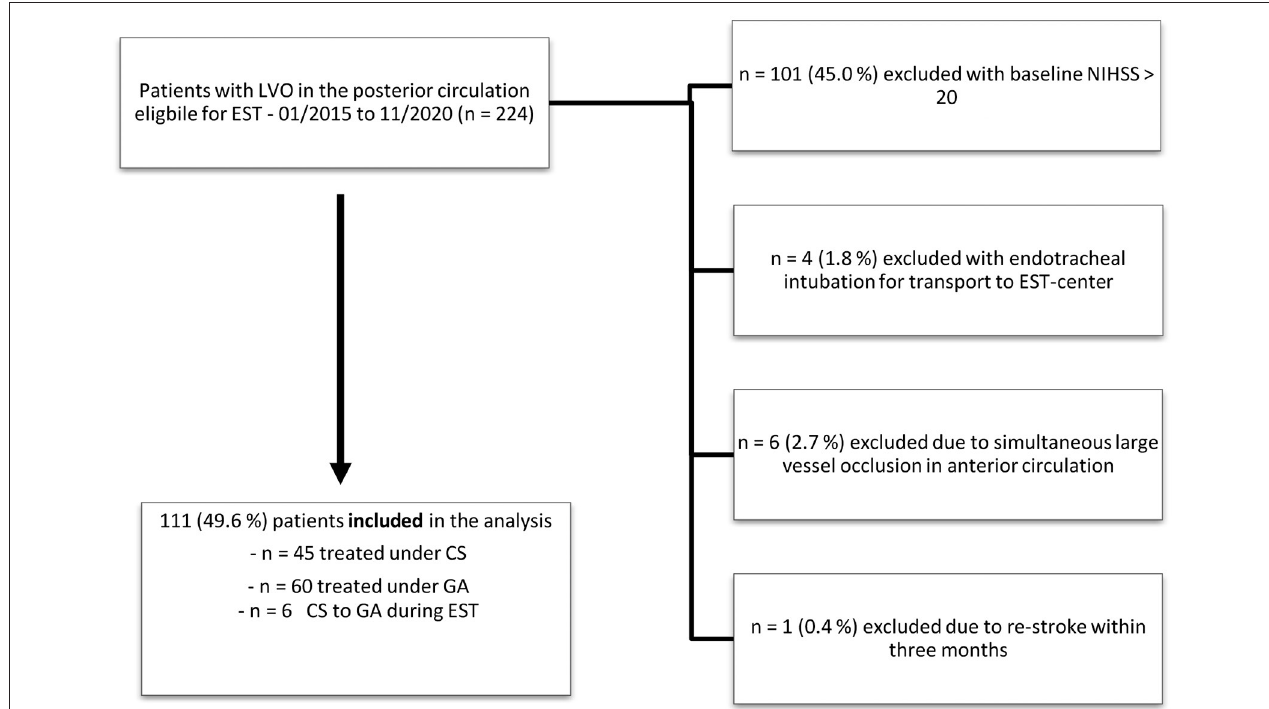
FIGURE 1 | Patient selection for comparison of patients with stroke in the posterior circulation according to the applied mode of anesthesia. EST, endovascular stroke treatment; NIHSS, National Institute of Health Stroke Scale; LVO, large vessel occlusion.